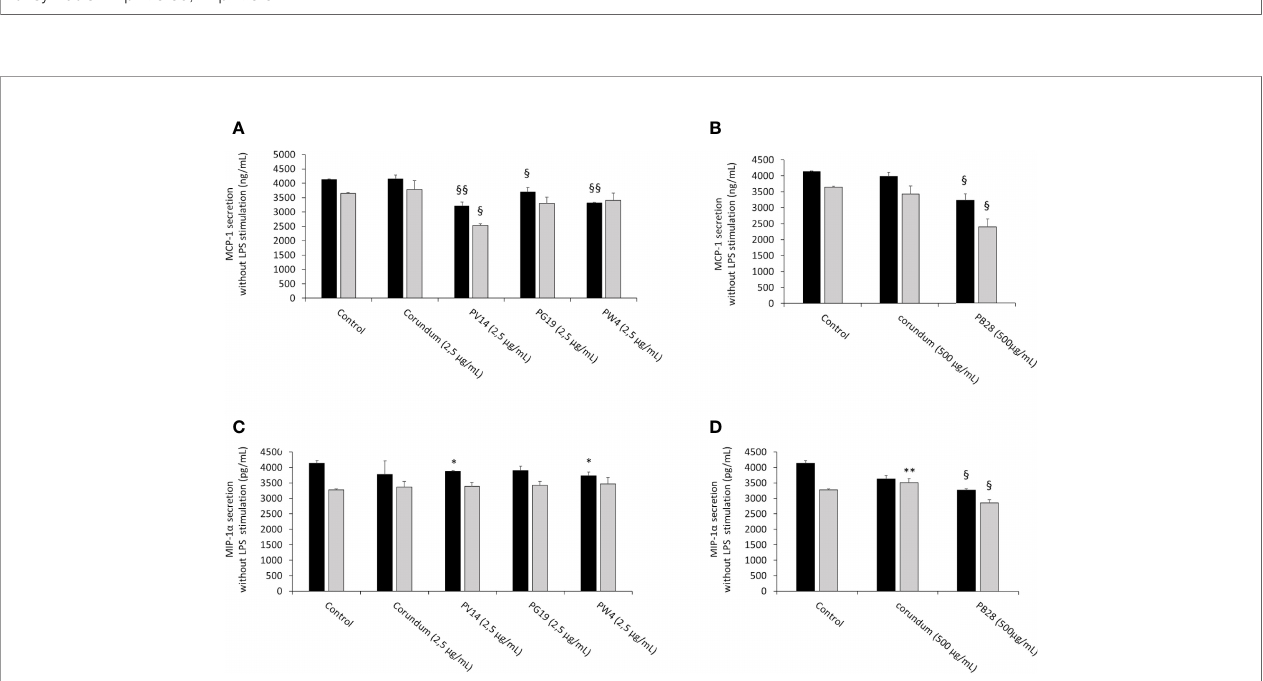
FIGURE 12 | chemoattractant cytokines secretion without LPS stimulation. Black bars: acute exposure (24 hours). Grey bars: exposure for 24 hours followed by a 3-day post-exposure recovery period. Panel (A) MCP-1 secretion. Conditions with 2.5 µg/ml of particle suspension. Panel (B) MCP-1 secretion. Conditions with 500 µg/ml of particle suspension. Panel (C) MIP-1 a secretion. Conditions with 2.5 µg/ml of particle suspension. Panel (D) MIP-1 a secretion. Condition with 500 µg/ml of particle suspension. Signi fi cance of symbols: *: different from negative control only; §: different from both negative and corundum controls. Number of symbols: 1: p < 0.05; 2: p <